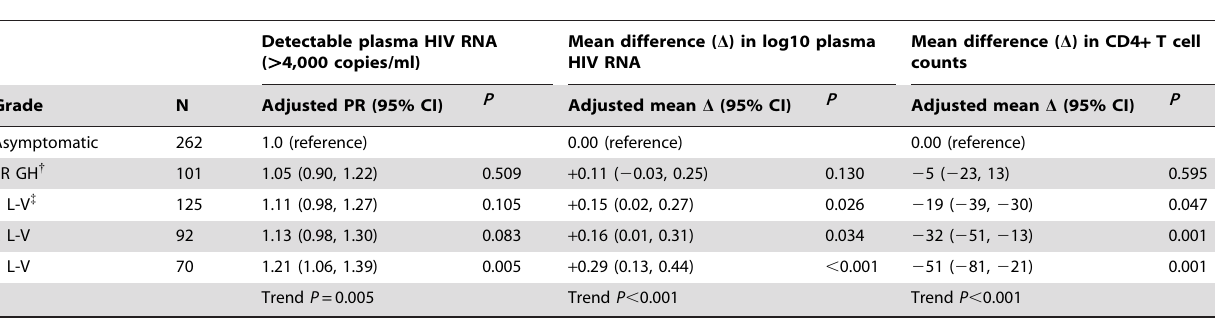
Table 4. Adjusted* prevalence risk ratios (PRs) of detectable plasma HIV RNA and mean differences in plasma HIV RNA and CD4 + T cell counts (from the GEE analysis with robust variance estimation) by degree of HSV-2 clinical